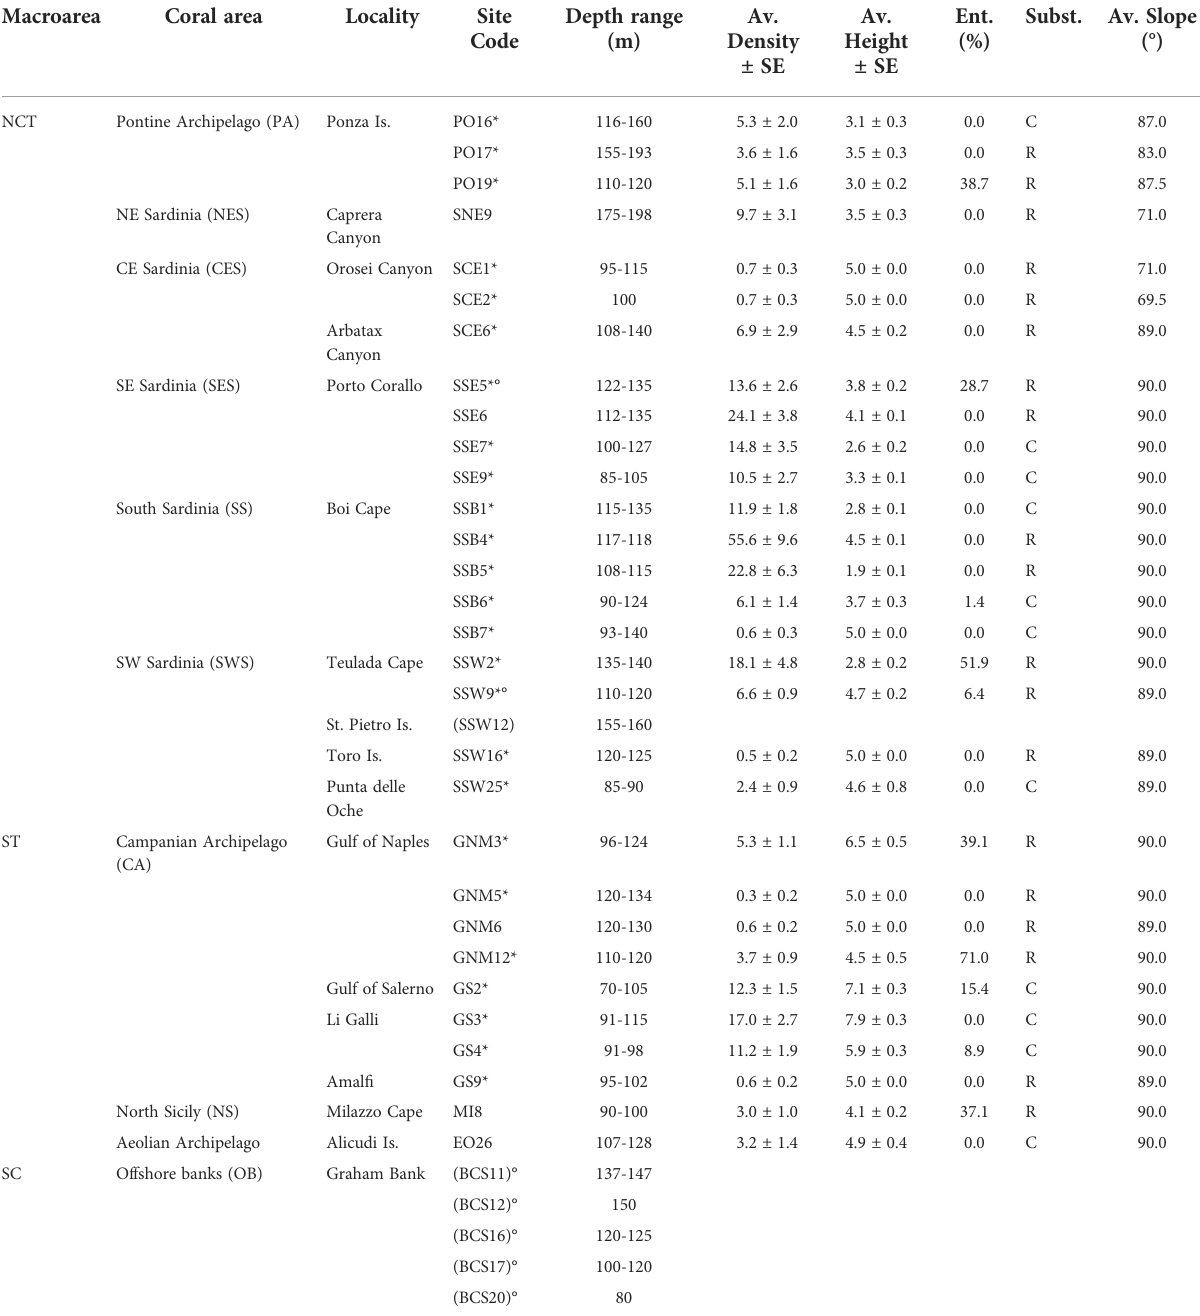
TABLE 2 Red coral mass